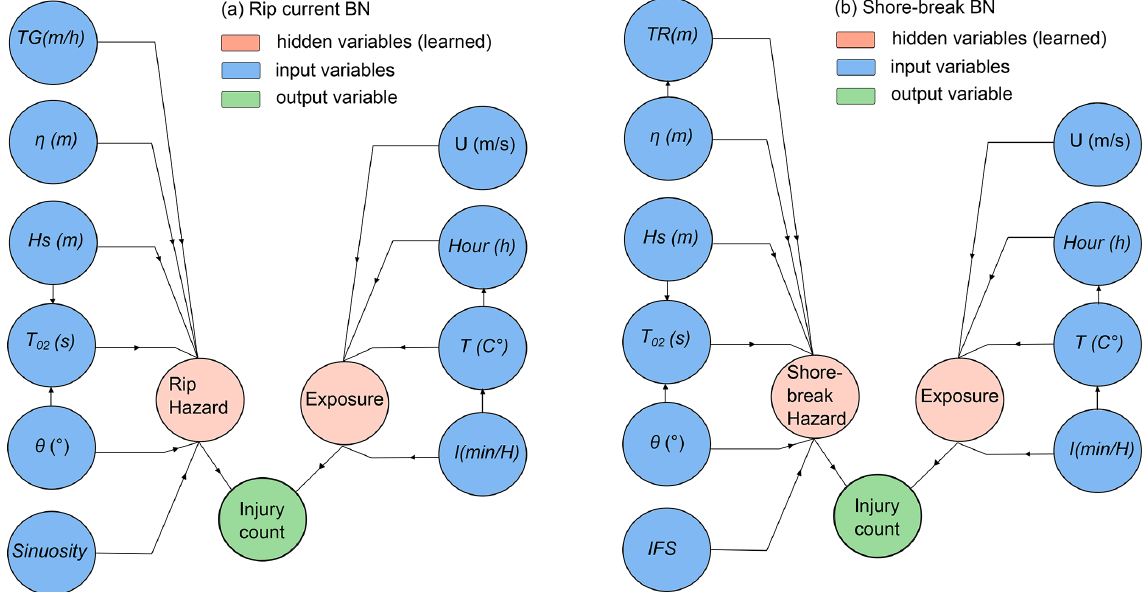
Figure 5. Bayesian networks for (a) rip-current-related injuries and (b) shore-break injuries. Both BNs are defined by input variables, hidden variables, an output variable and their